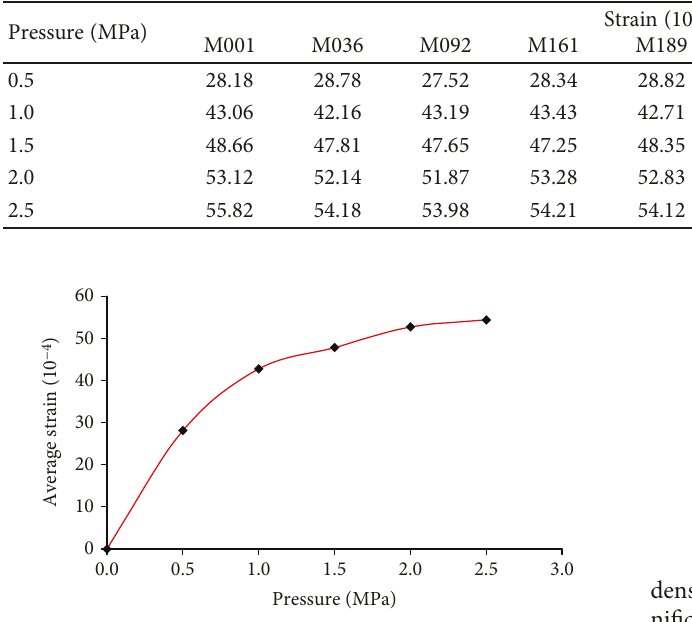
Figure 6: The average strain of the coal sample under di ff erent pressures.